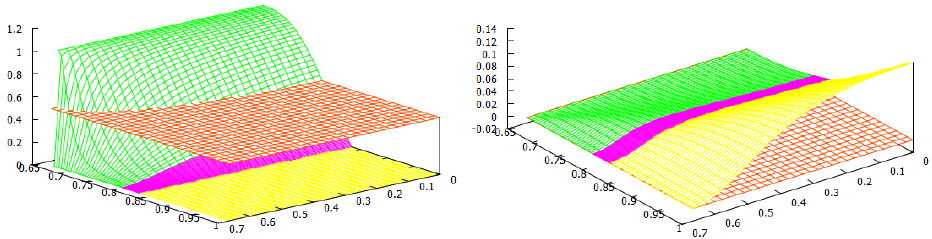
Figure 6. Left : The Nash custom revenue share ShCR N consumer surplus share difference ∆ ShCS j of country X j . See Equations (19) and